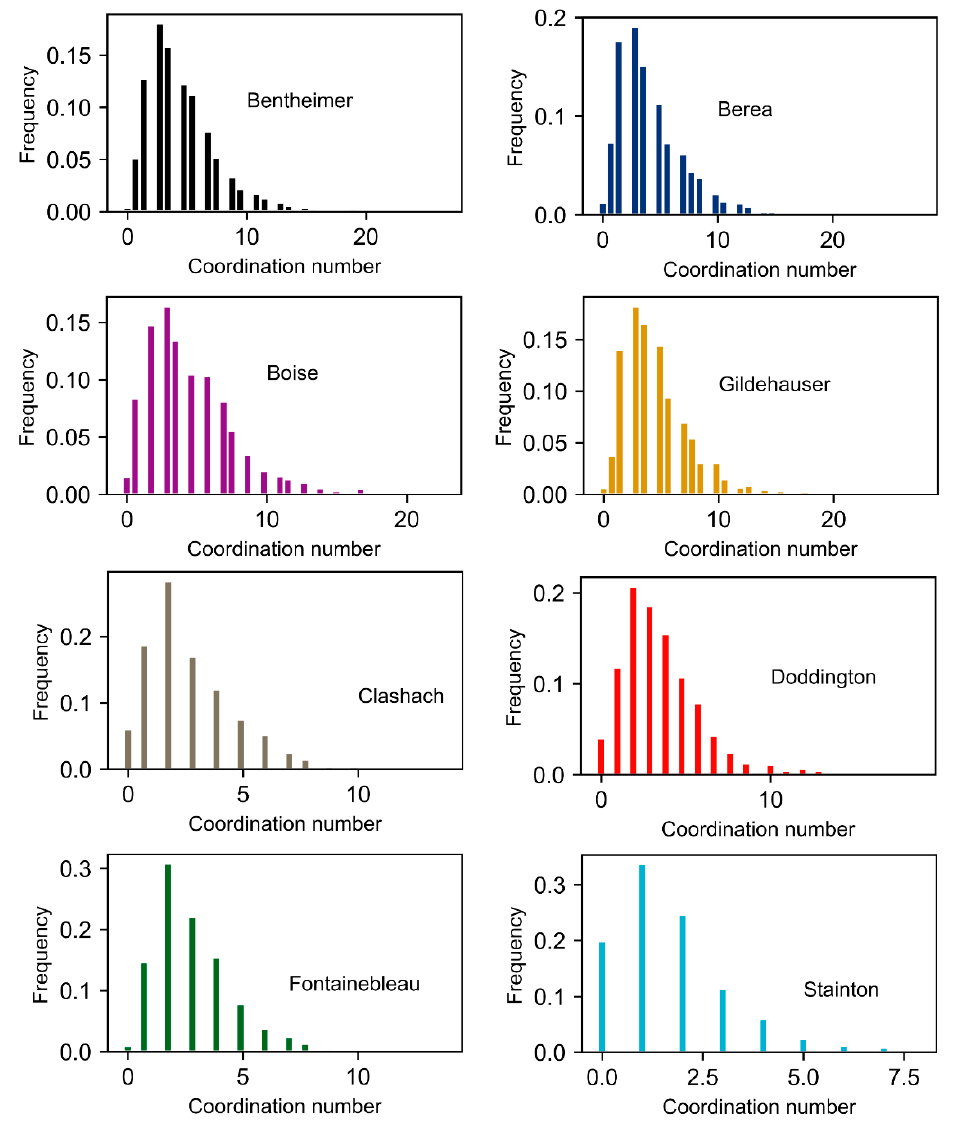
Figure 9. Pores coordination number distribution.